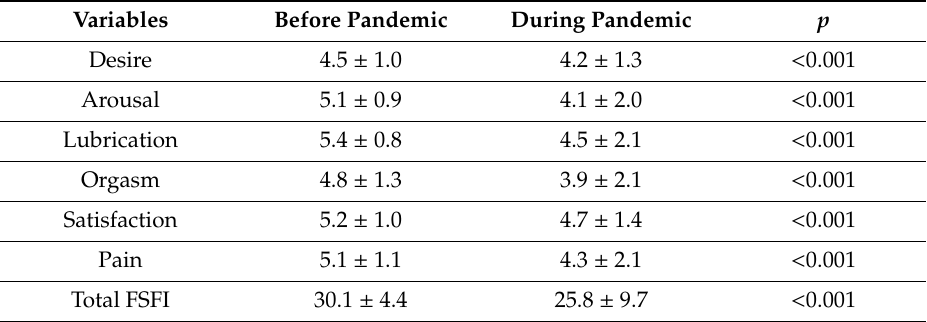
Table 2. Female Sexual Function Index (FSFI) before and during pandemic. Variables Before Pandemic During